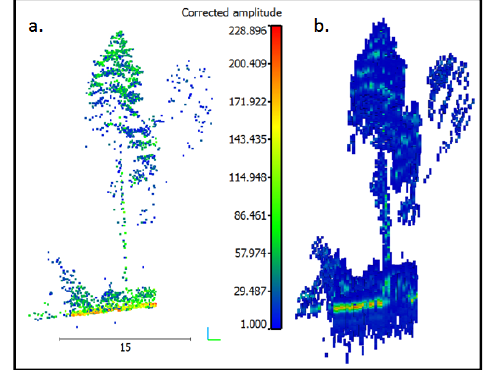
Figure 11. Visualisation of a spruce coloured by attenuation- corrected amplitudes: Point based (a) and voxel based representation (b) of waveform data The generated voxel space contains 88674 voxel (Tab. 5)